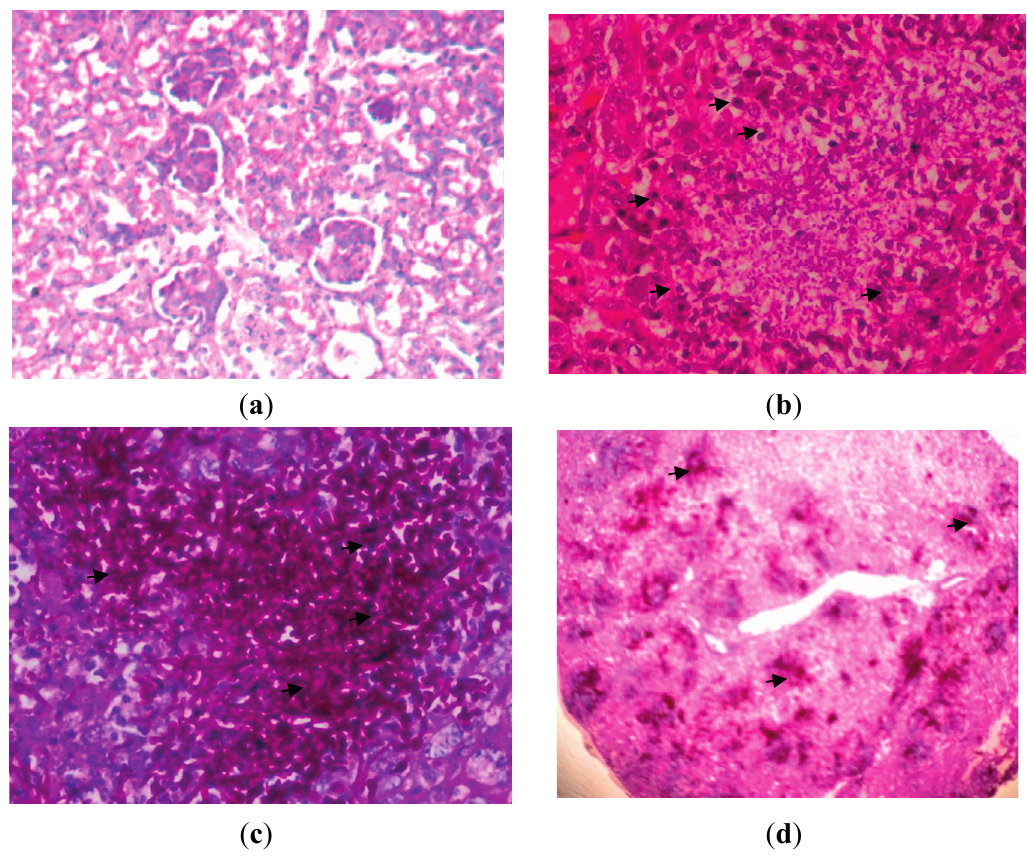
Figure 4. Kidney tissues on 72 h post-infection with C. albicans , ( a ) uninfected kidney; Haematoxylin-eosin (H&E) stain; original magnification, ×400 (Tissues were normal, no congestion of tubules, inflammation, haemorrhage and glomeruli); ( b ) H&E stain; original magnification, ×400 (Arrows indicated a large polymorphonuclear infiltrate is demonstrated in the abscess in the center of the photomicrograph); ( c ) Periodic acid Schiff (PAS) stain; original magnification, ×400 (Arrows indicated hyphae and fungal bodies of C. albicans ); and ( d ) PAS stain; original magnification, ×40 (Arrows indicate that here there is confluent invasion of the hyphae and fungal bodies in the